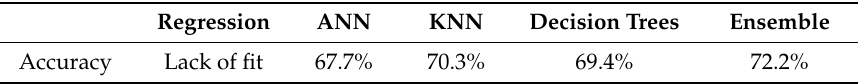
Table 2. Accuracy without data